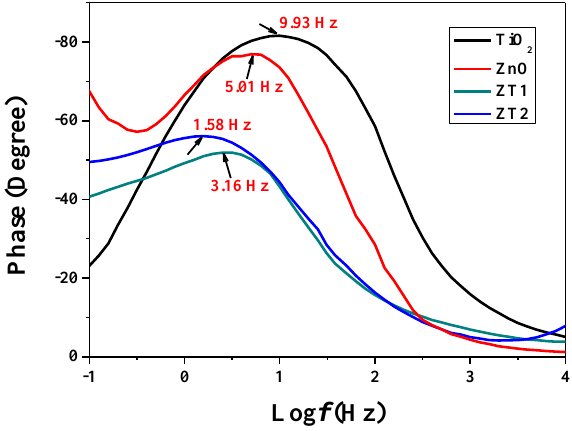
Figure 6. Bode-phase plots of the prepared photoanode films measured in 0.1 M Na 2 SO 4 solution in dark state.